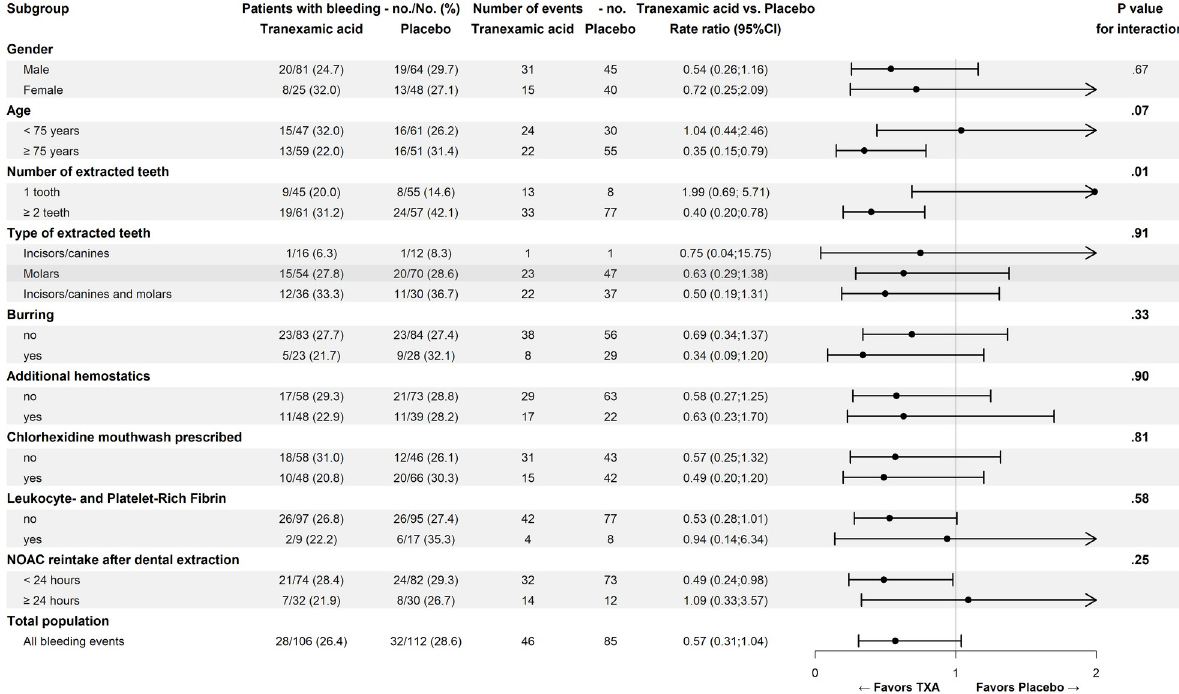
Fig 4. Estimated rate of oral bleeding according to patient and surgical characteristics. no./No. = the number of patients with oral bleeds divided by the total number of patients in the subgroup; no. = number of oral bleeding events. The rate ratios are given for the number of oral bleeding events and are obtained by means of a negative binomial regression. CI, confidence interval; NOAC, non-vitamin K oral anticoagulant; TXA, tranexamic acid.